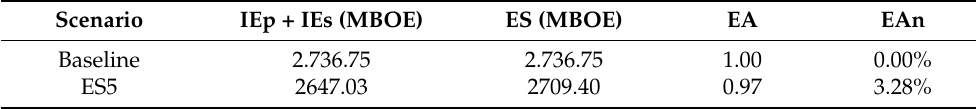
Table 16. Autarky.